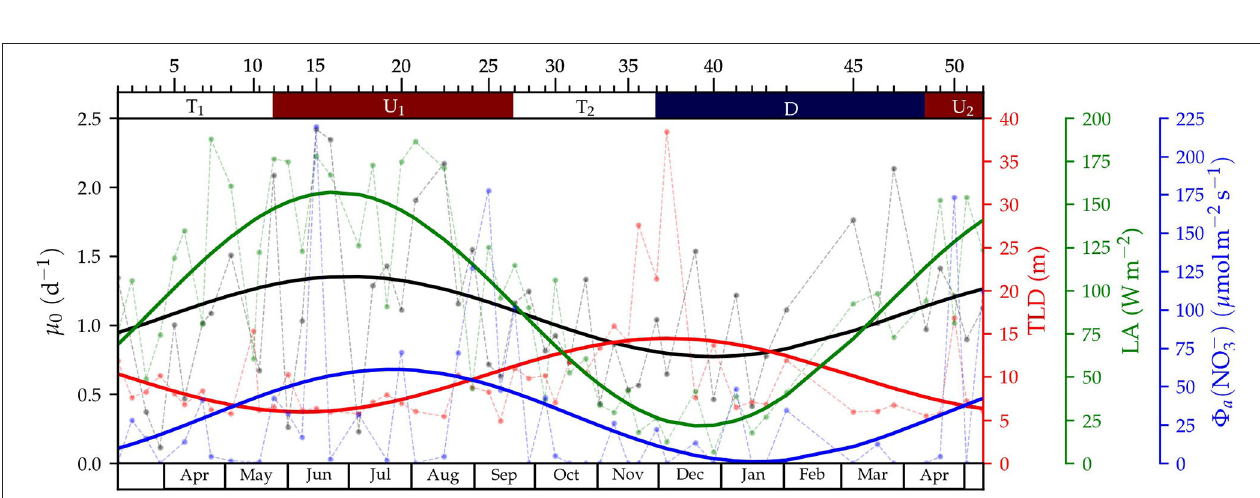
FIGURE 5 | Time-series of surface phytoplankton growth rates ( µ 0 , black), turbulent layer depth (TLD, red), light availability (LA, green) and nitrate advective flux [ 8 a (NO − 3 ), blue]. Data for each sampling is represented by circles connected by a dashed line, and the seasonal mode (computed by fitting to a sinusoidal function), with a solid line. The ticks and numbers at the top axis indicate the sampling number and the colors, the periods for upwelling (U 1 and U 2 , in red), downwelling (D, in blue), and transition (T 1 and T 2 , in white).